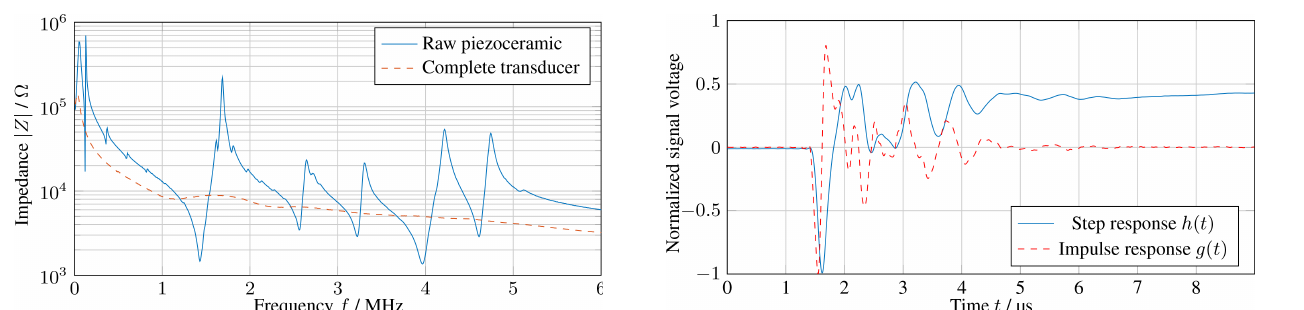
Figure 2. Absolute value of the ceramic’s electrical impedance be- fore and after embedding in the damping mass.